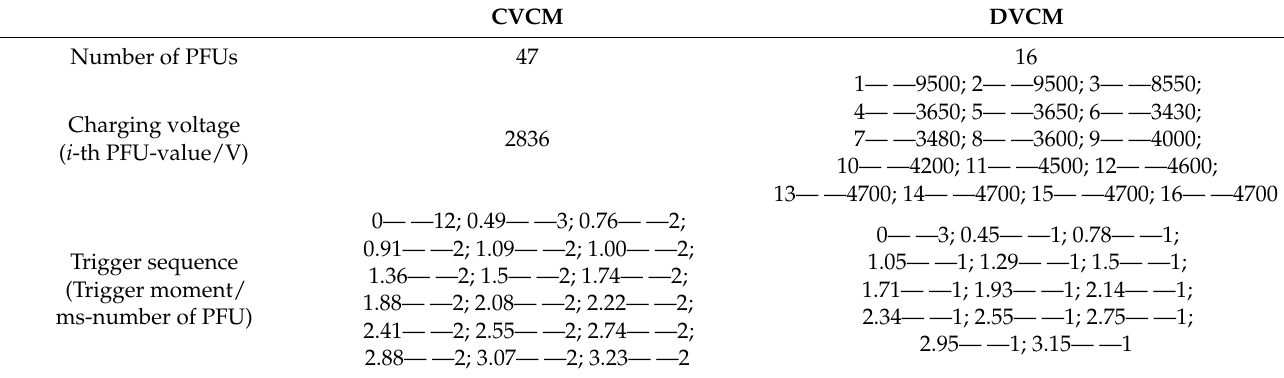
Table 3. Calculation results based on the CVCM and